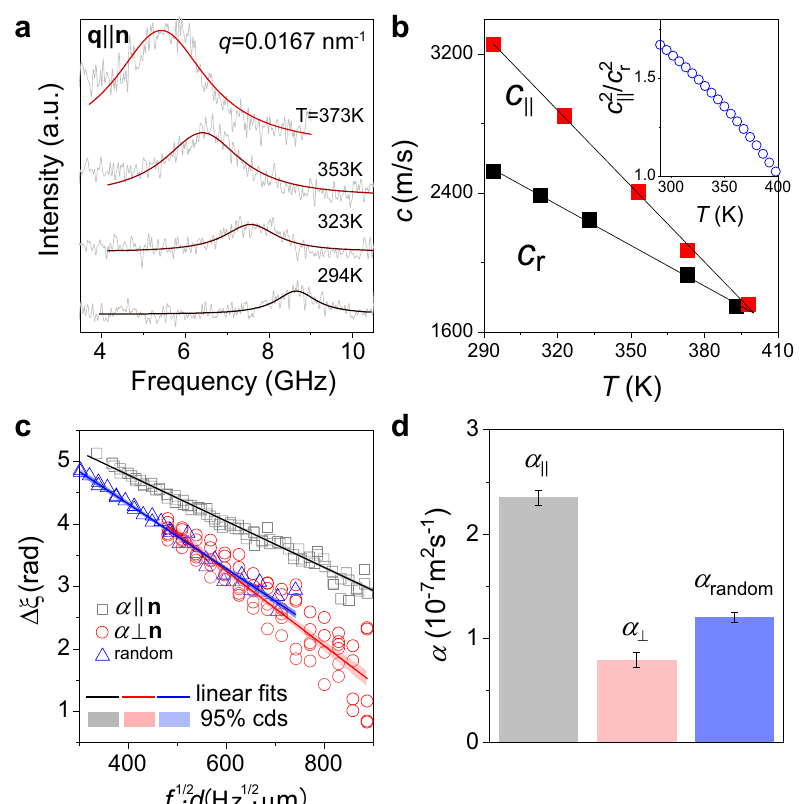
Fig. 4 | Temperature-dependent elasticity and anisotropic thermal diffusivity. a EvolutionofpolarizedBLSspectrawiththetemperatureatagiven q parallelto n . b Thetemperature-dependenceof c || inmonodomainLCEand c r inpolydomainLCE along with their ratio shown in the inset. The solid lines denote linear representa- tion of the temperature-dependent sound velocities. c The phase delay Δ ξ of the heatwavestraversing theLCE fi lmswithathickness d asafunctionof f 1/2 · d , where f